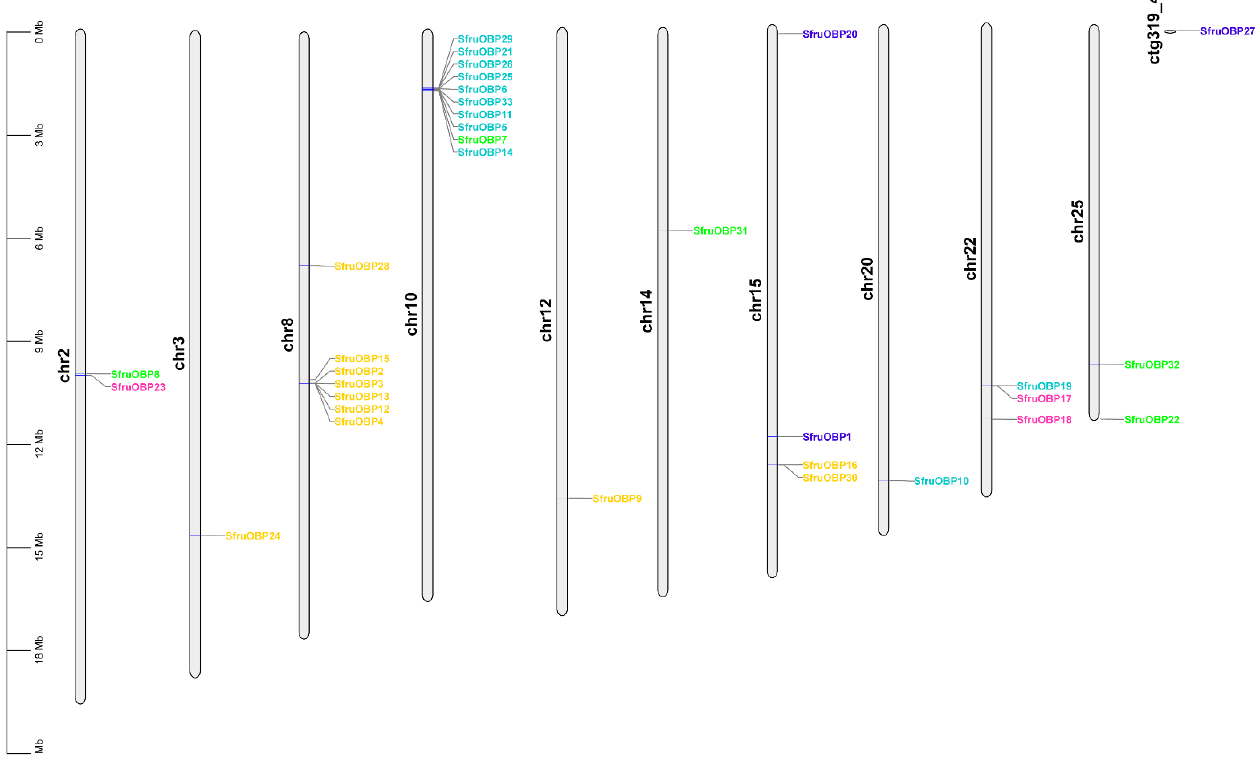
Figure 3. Chromosomal localization of the SfruOBP genes based on the genome data of S. frugiperda . Different colors of gene names indicate OBPs from specific Clusters as indicated in Figure 1: cyan, Cluster 1; pink, Cluster 2; bright green, Cluster 3; blue, Cluster 4; orange, Cluster 5. Contrary to SfruOBP s, the distribution of SfruCSP s seems to be more centralized, having identified loci on only two chromosomes: two genes of Cluster 2 ( SfruCSP2 / 20 ) are located on adjacent loci of chromosome 19, while the remaining 21 genes of Clusters 1, 2, 3, and 4 are all located on chromosome 8 (Figure 4). On this chromosome, most of the genes fall in proximal loci, with the exception of SfruCSP 1 and SfruCSP 12, located at 3.5 Mbp and 6.6 Mbp, respectively, on the chromosome.